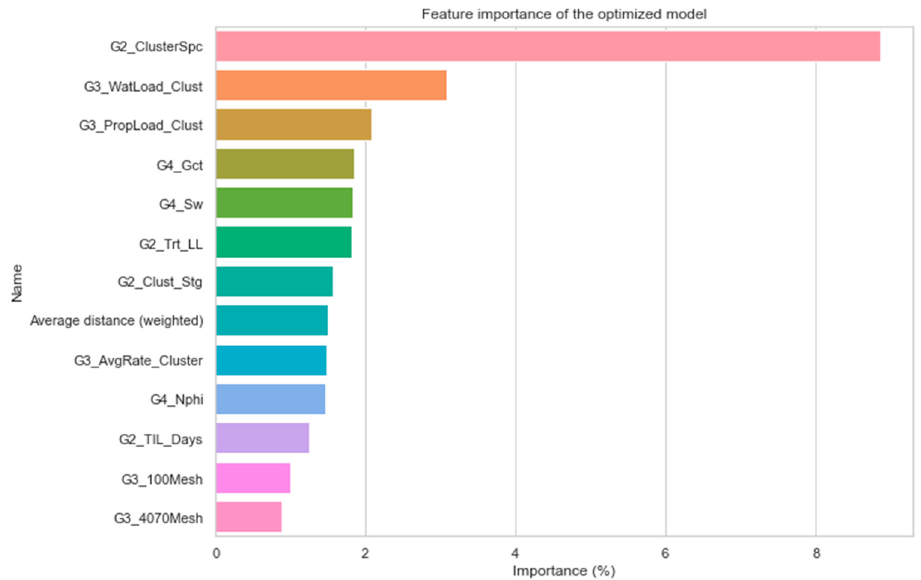
Figure 11. Feature importance of the optimized model.